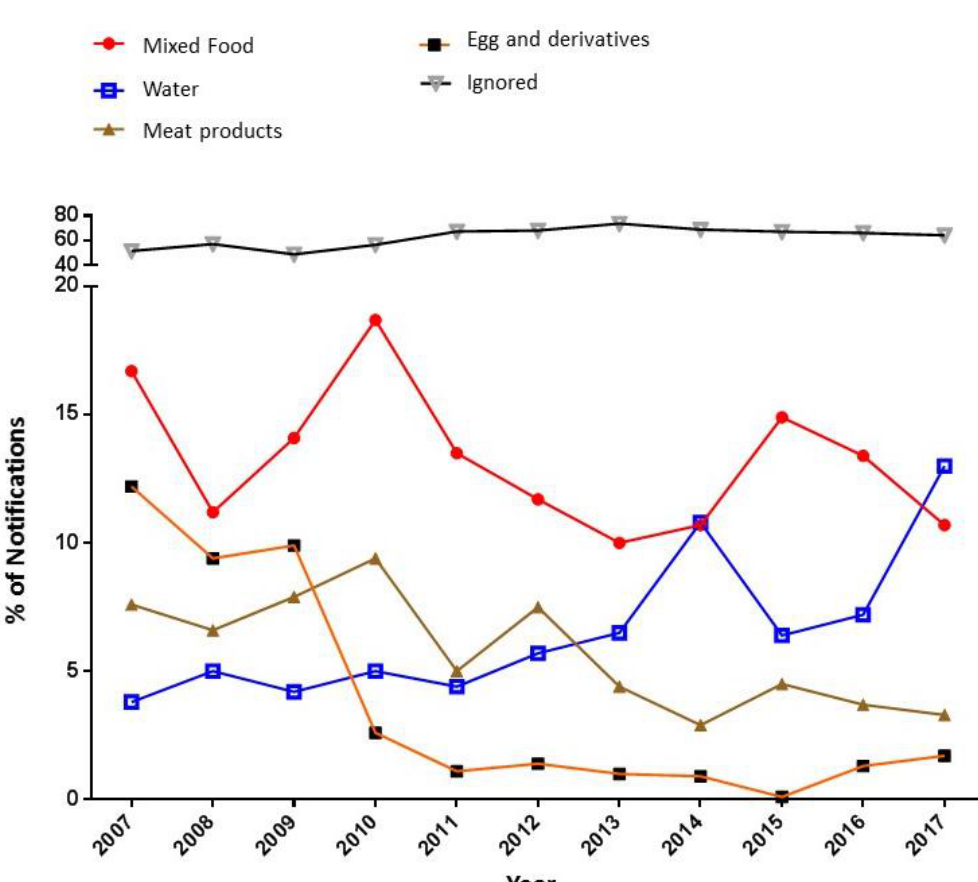
Figure 2. Percentage of notifications according to the food category between the years 2007 and 2017.